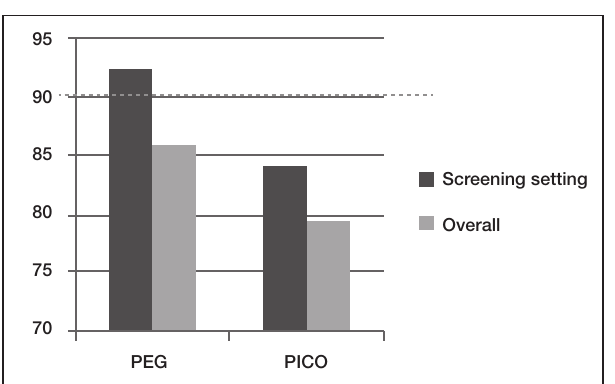
Figure 1) Indications for colonoscopy